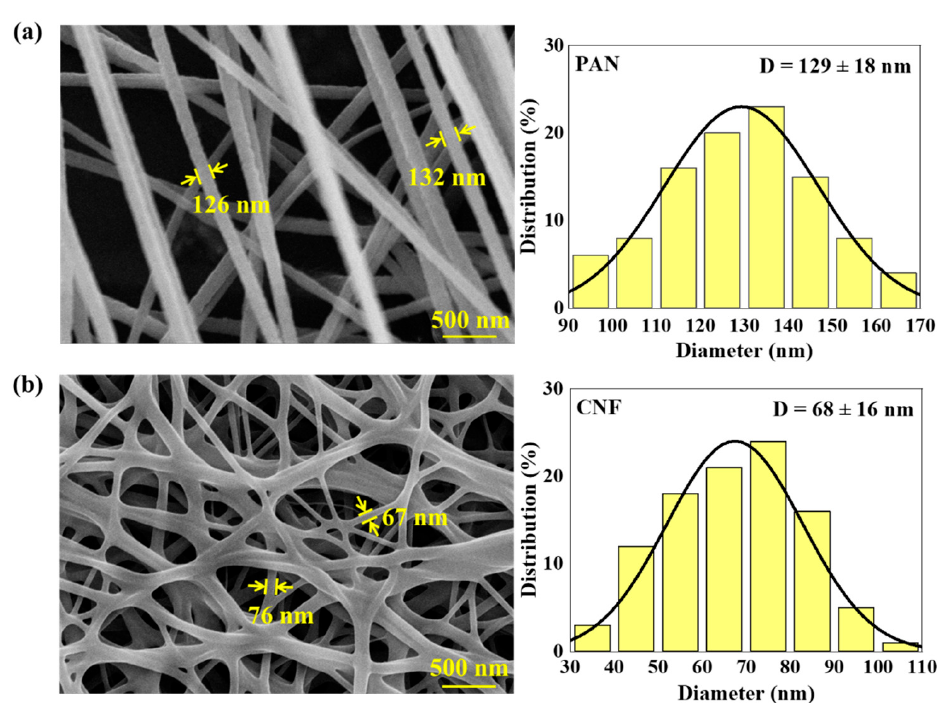
Figure 2. Representative SEM images of electrospun nanofibers ( a ) before and ( b ) after carbonization.